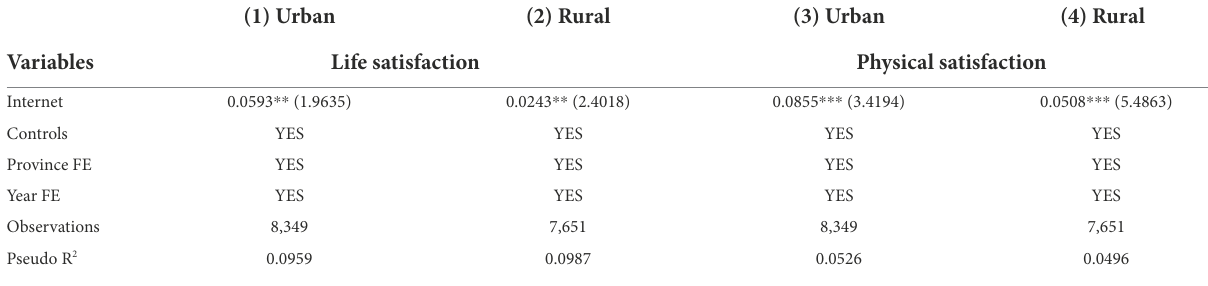
TABLE 8 Urban–rural heterogeneity.